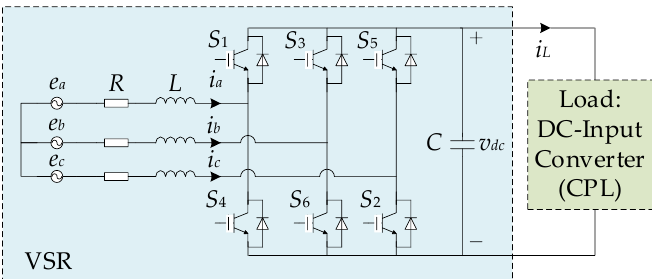
Figure 1. Schematic of three-phase VSR cascaded with a DC-input converter.